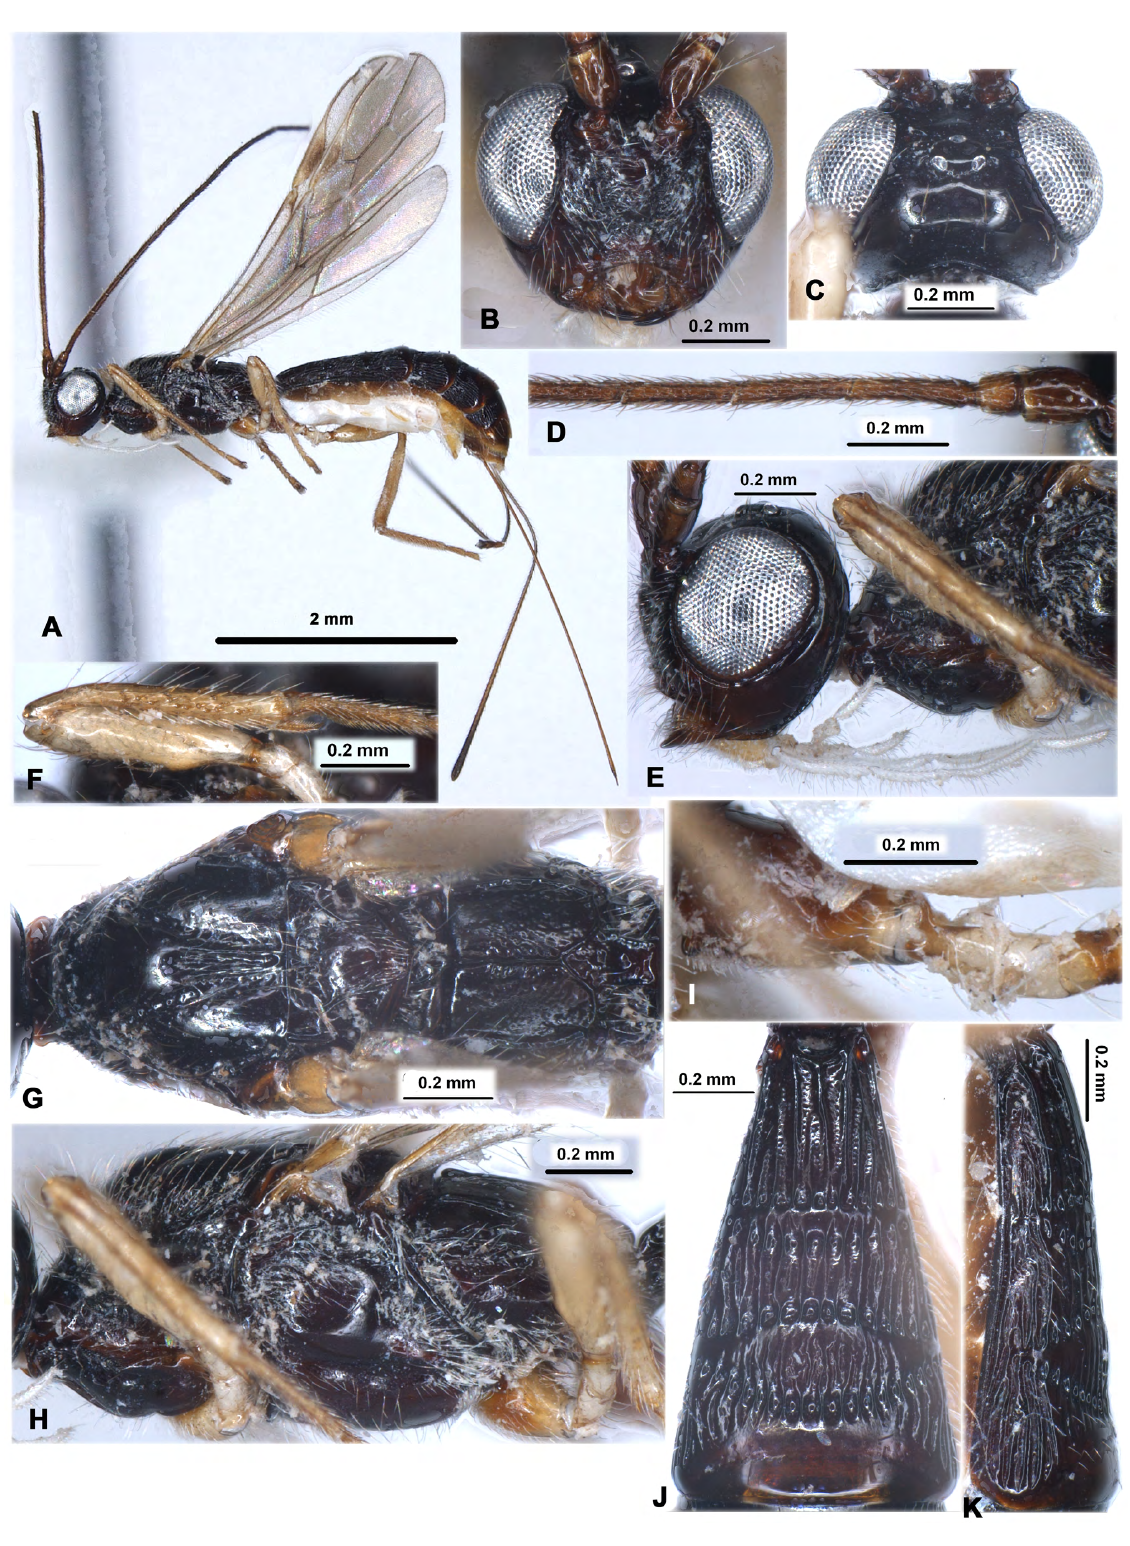
Fig. 3. Arhaconotus papuanus Belokobylskij, 2000, ♀, holotype, TAMU. A . Habitus, lateral view. B . Head, front view. C . Head, dorsal view. D . Basal segments of antenna. E . Head, lateral view. F . Fore leg. G . Mesosoma, dorsal view. H . Mesosoma, lateral view. I . Hind coxa. J . First to third metasomal tergites, dorsal view. K . First to third metasomal tergites, lateral